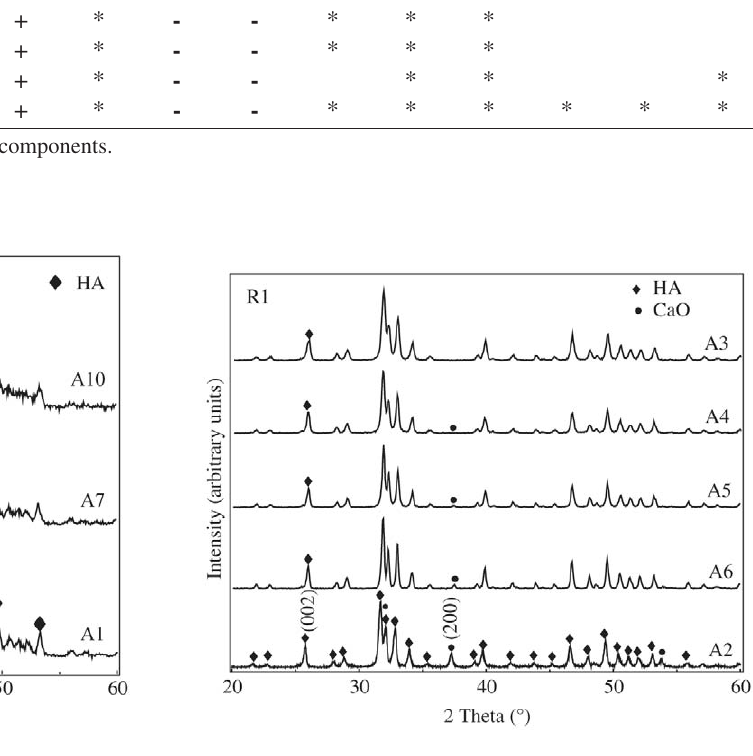
Figure 5. XRD patterns of the synthetic precipitate powders after thermal treatment on